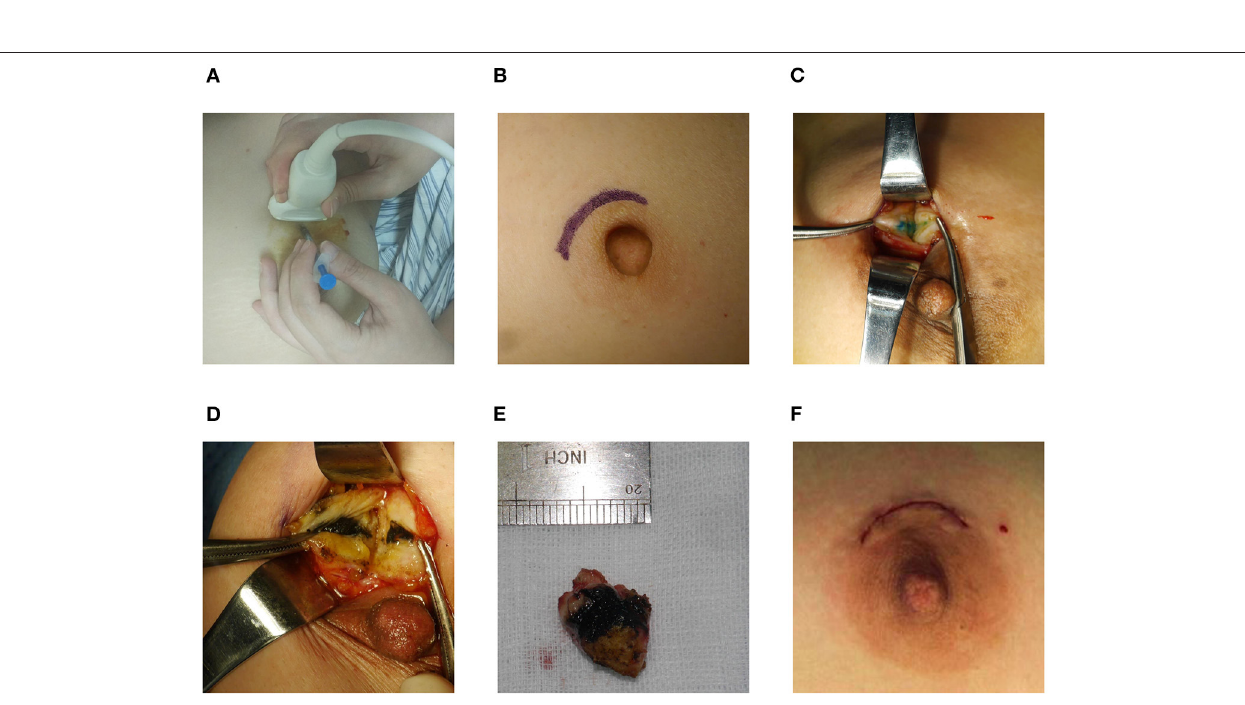
Frontiers in Surgery |